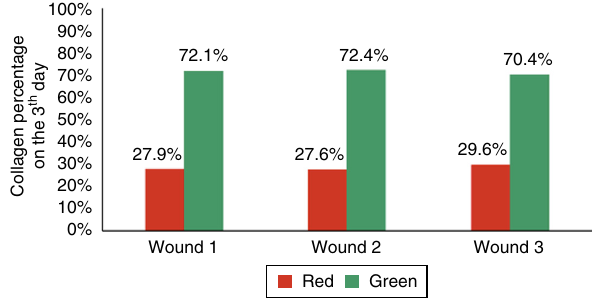
Demonstration of the percentage of type I and type III collagen on the third day of the experiment in the three wounds.